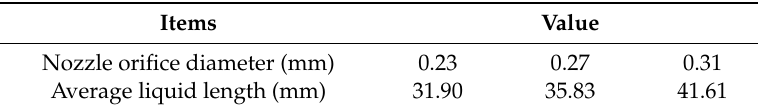
Table 5. The average liquid length of the spray.